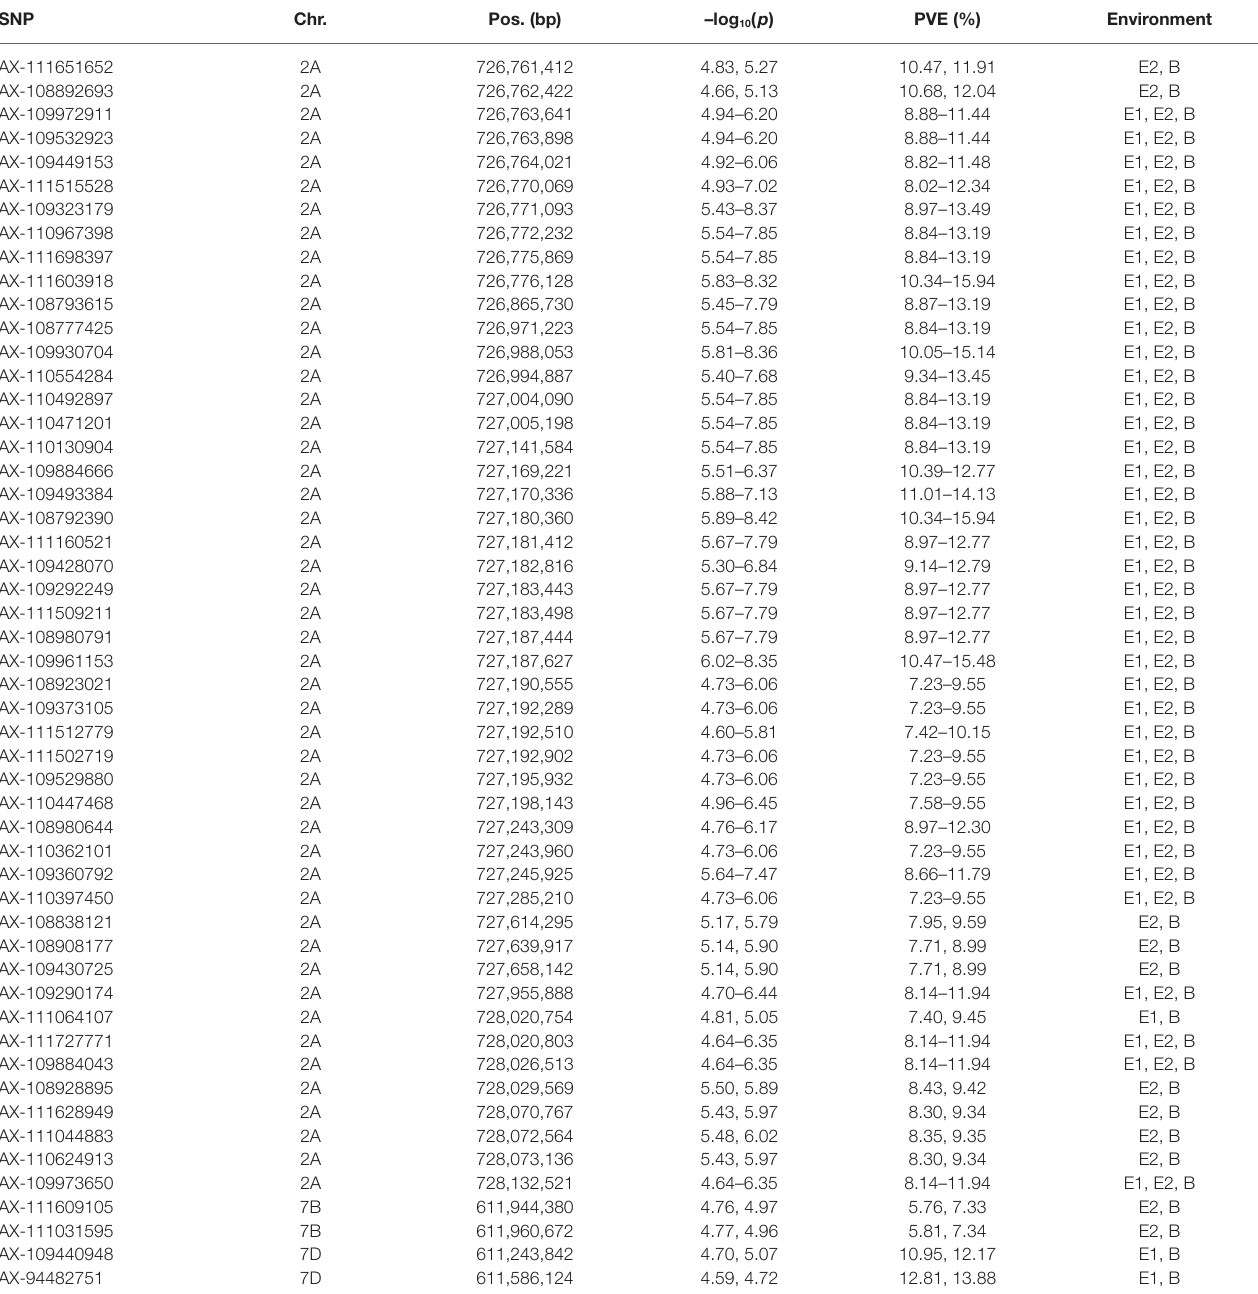
TABLE 2 | Summary of common SNPs significantly associated with GMoC by GWAS. SNP Chr. Pos. (bp) –log 10 ( p ) PVE (%) Environment